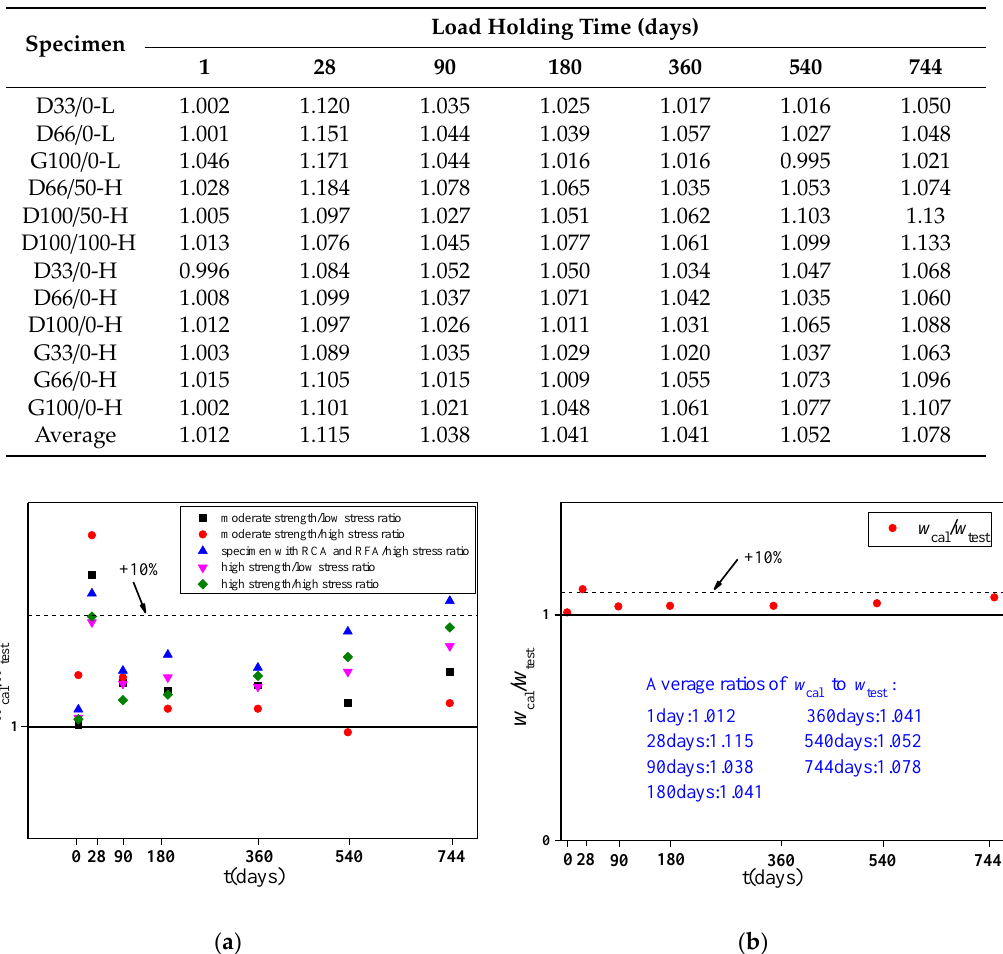
Figure 18. Comparisons between the test results and the calculated results. ( a ) Ratios of the different types of specimens; ( b ) average ratios of the specimens.